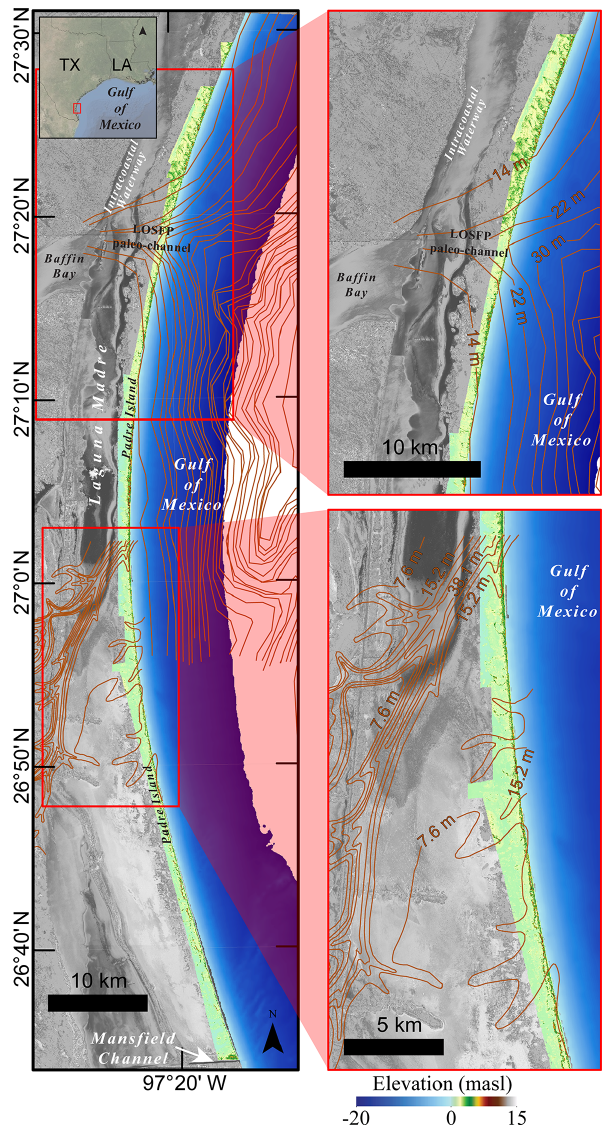
Figure 1. Padre Island National Seashore represents an ideal lo- cation to test for a directional influence of the framework geology because of the variability in the surface morphology, represented by the topobathy digital elevation model (DEM), and the underlying framework geology, represented by the Pleistocene paleo-surface contour lines from Fisk (1959) and MIS II paleo-surface contour lines from Anderson et al.